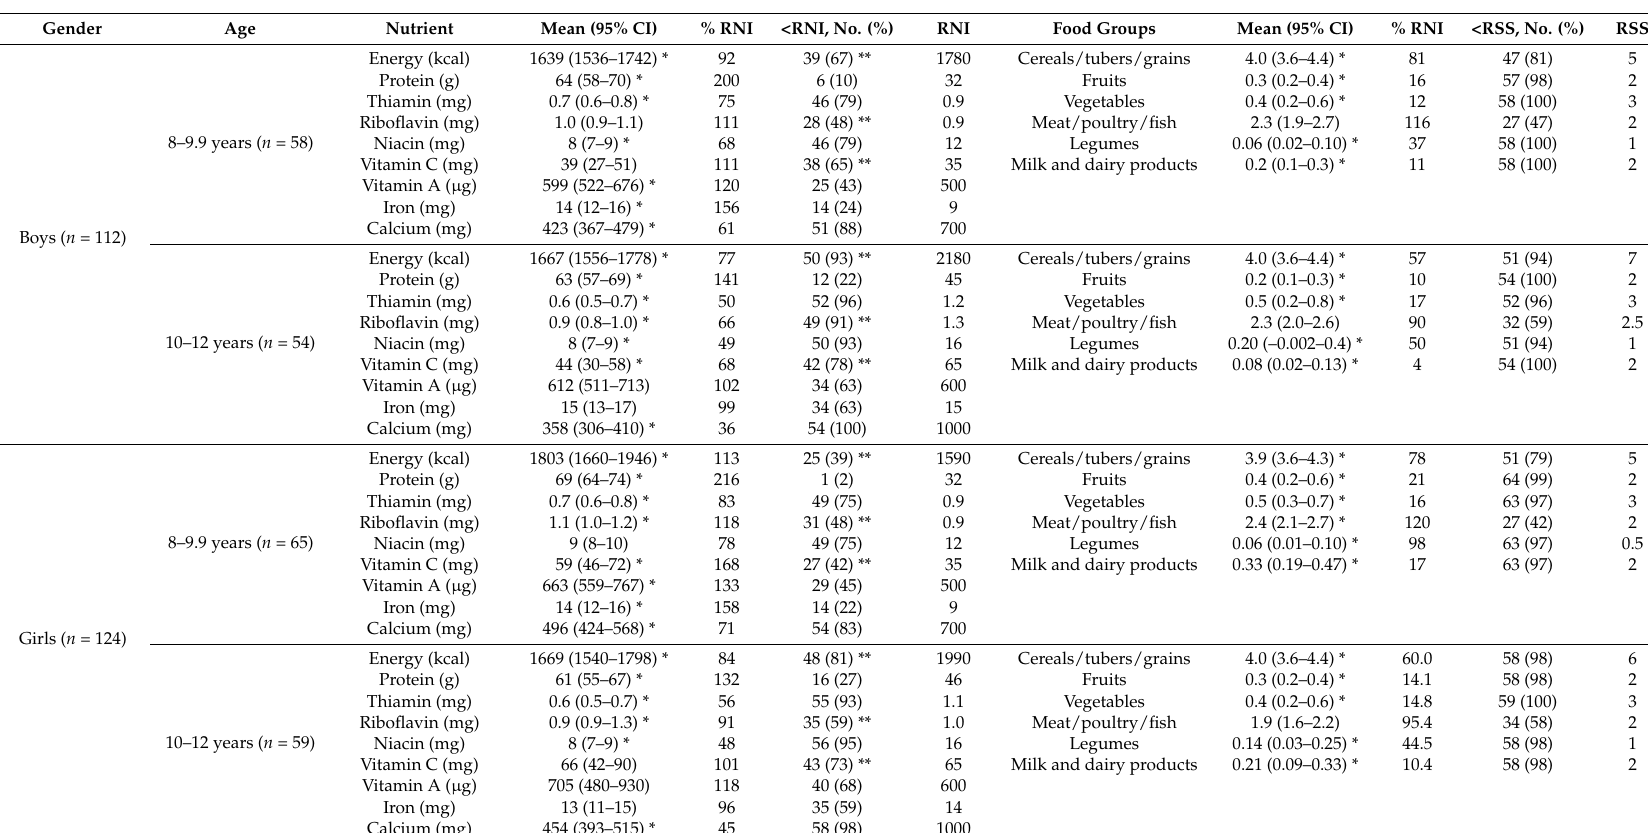
Table 2. Dietary intakes of children compared with the Malaysian Recommended Nutrient Intake (RNI) and Malaysian Dietary Guidelines Recommended Serving Size